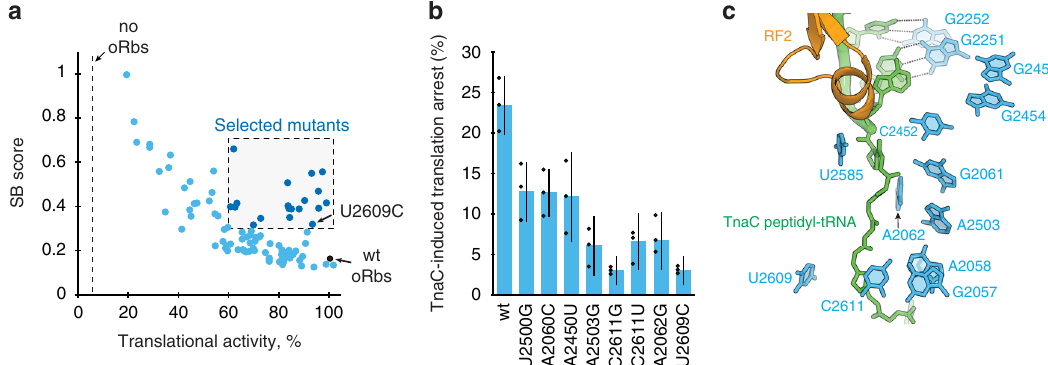
Fig. 8 Selection of the gain-of-function mutations using OSYRIS. a Translational activity and stalling bypass (SB) score of the PTC library mutants expressing the orthogonal GFP-TnaC reporter in the OSYRIS cells. The dots representing the mutants exhibiting ef fi cient termination (SB score > 0.3) while maintaining high ef fi ciency of translation (>60% of the wt control) are shown in a darker shade of blue. The dotted line indicates the background level of expression of the orthogonal GFP-TnaC(W12R) mutant in the Ribo-T cells lacking oRbs. The black dot indicates the translation of the o-reporter by oRbs with wt 23S rRNA. b Testing ribosomes with gain-of-function mutations in a cell-free translation system (see Supplementary Fig. 11c). Ribosomal 50S subunits with lethal mutations (U2500G, A2060C, and A2450U) were isolated from OSYRIS cells and combined with wt 30S subunits. The ribosomes with non-lethal mutations were isolated from SQ171 cells (see Supplementary Table 2). The bar graph represents the mean ± s.d. of the three independent experiments. Statistical signi fi cance of the difference from wt values was determined by Student ’ s t test. c The placement of the 23S rRNA residues (blue) whose mutations resulted in gain-of-function (dark blue dots in panel a ) relative to the TnaC-tRNA (green) and RF2 (orange) in the structure of the TnaC- stalled ribosome 30 .